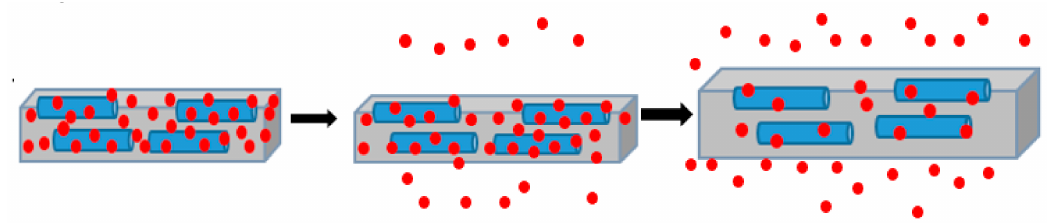
Figure 11. Schematic representation of API release mechanism for PLA / HNT / ASP nanocomposite through di ff usion and